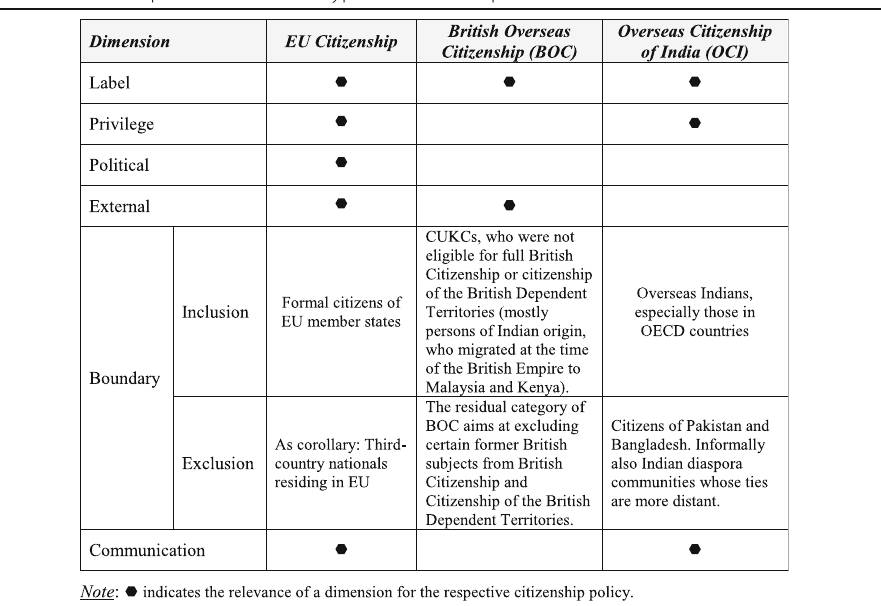
Table 1 Citizenship Dimensions for Atypical Membership Policies